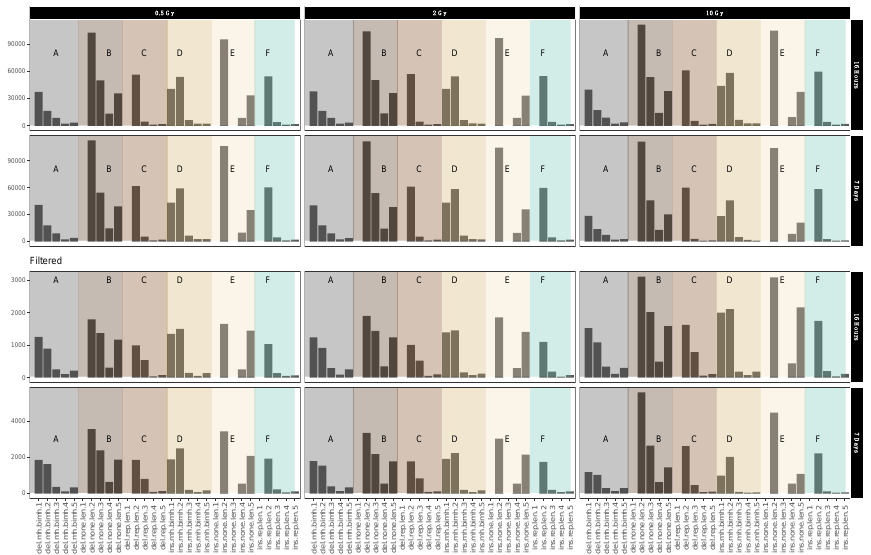
Figure A7. Mutational IR-induced signature plot (dataset 2). On the X-axis the length and specific vicinity of InDels are represented while the Y-axis (note differing scales) shows the InDel count. See Table 3 for pertaining terms and definitions.